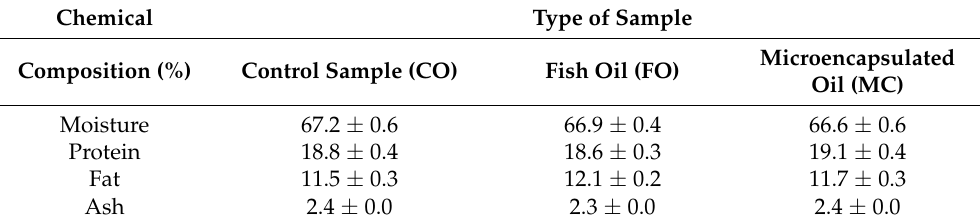
Table 1. The basic chemical composition of the poultry